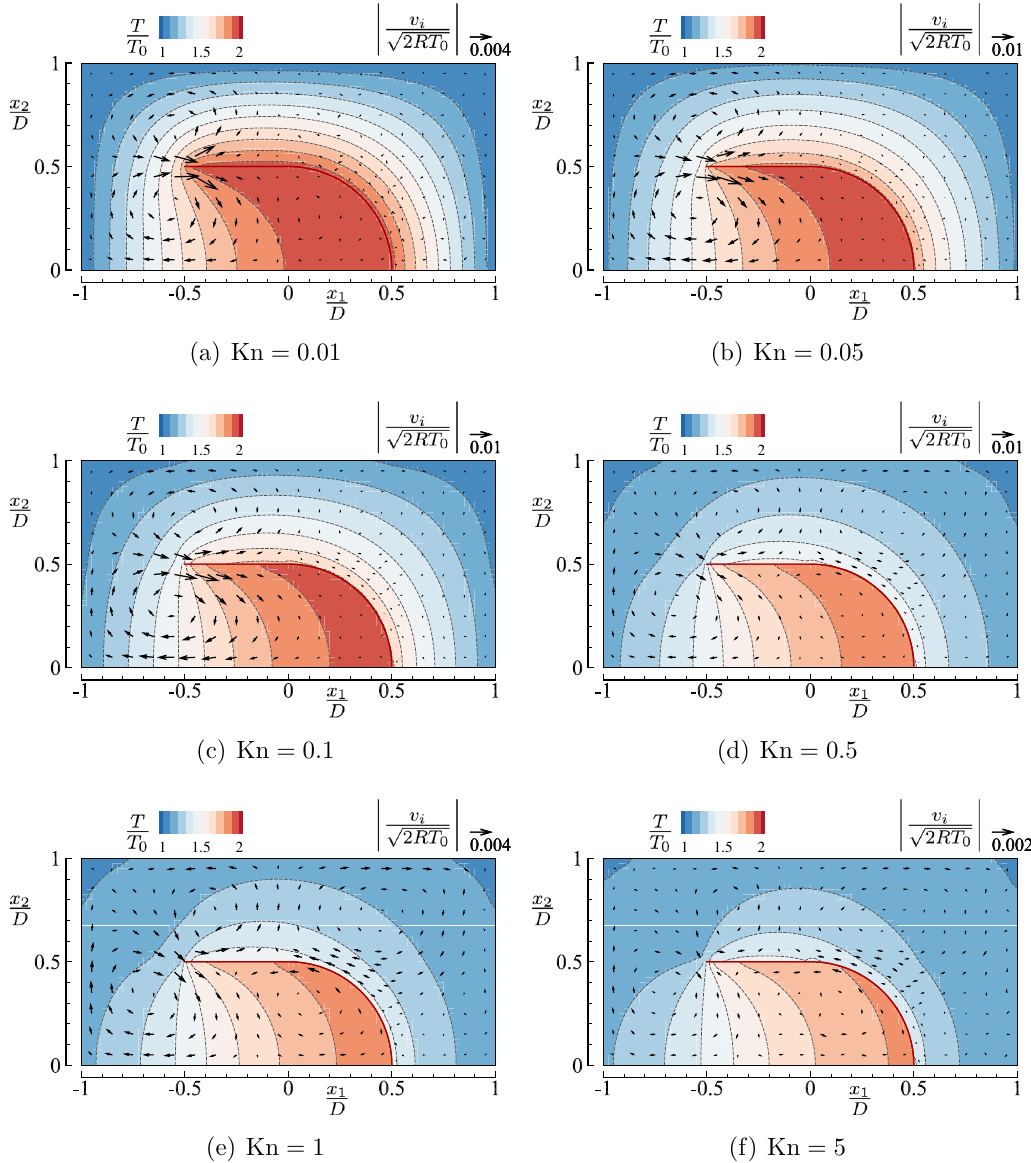
Figure 5. Flow velocity vector ( v 1 , v 2 ) and contour map T in the case of a single round-U body in a closed 2 , H / D 2 , and L / D 1 ) for typical Knudsen numbers Kn vessel ( T 1 / T 0 = = = 0.5, ( e ) 1, and ( f ) 5. See the caption of Fig.